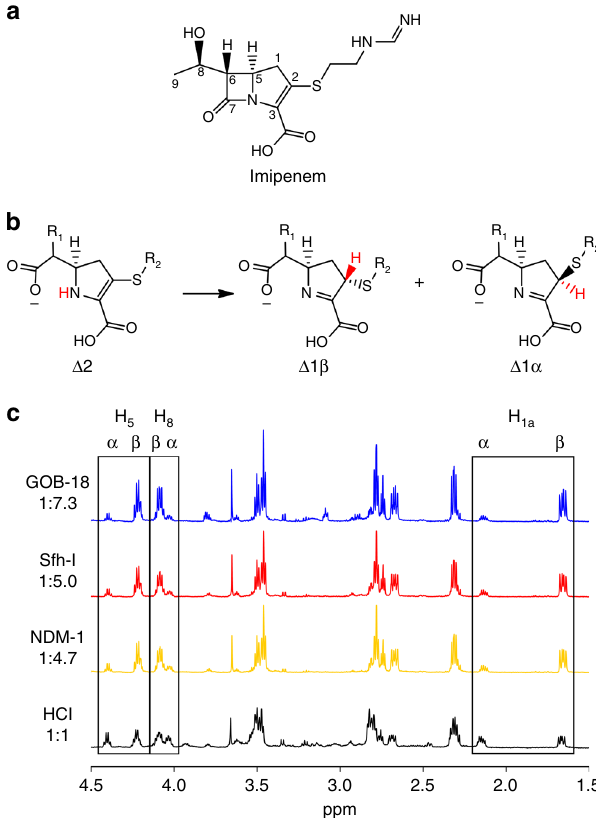
Fig. 5 Analysis of the population of tautomers in the M β L-catalysed imipenem hydrolysis. a Structure and atom numbering of imipenem. b Tautomeric structures of hydrolysed imipenem. c 1 H-NMR spectra of the products of imipenem hydrolysis by mono-Zn(II)-GOB-18 ( blue ), mono-Zn (II)-Sfh-I ( red ), bi-Zn(II)-NDM-1 ( yellow ), and HCl ( black ). In all cases only tautomer Δ 1 was detected. Signal assignments are indicated on top and were taken from Ratcliffe et al. 39 . The α : β diastereomer ratio is indicated on the